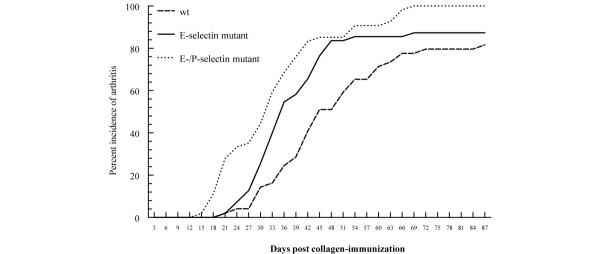
Incidence of CIA in E-selectin mutant, E/P-selectin mutant, and wild-type mice. E-selectin mutant (n = 56), E/P-selectin mutant (n = 54), and wild-type mice (n = 48) were immunized with chick type II collagen and assessed for the development of arthritis for 90 days by a blinded observer. The results are presented as the mean of three separate CIA experiments. The cumulative number of mice in each group is given as a percentage. CIA, collagen-immunized arthritis; wt, wild-type.